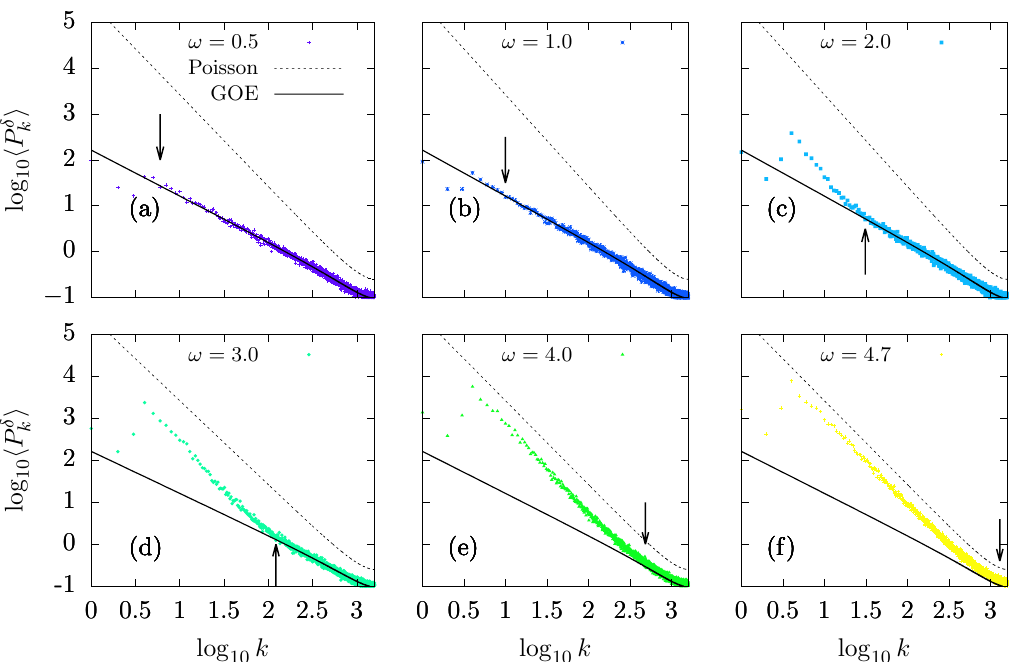
〉 , for six values of disorder strength , 〈 P δ n k for the corresponding value of ω . All min